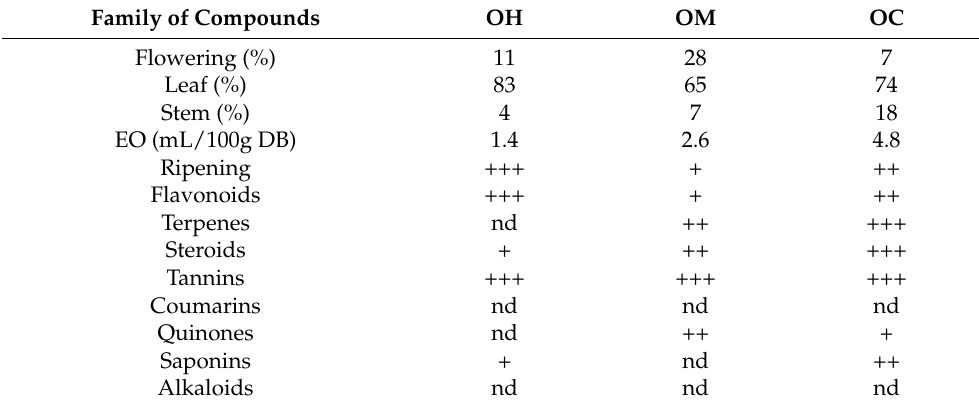
Table 1. Physiochemical and phytochemical analysis of Mexican oregano samples from 3 regions: oregano from Huejuquilla (OH), from Mezquitic (OM) and from Colotlan